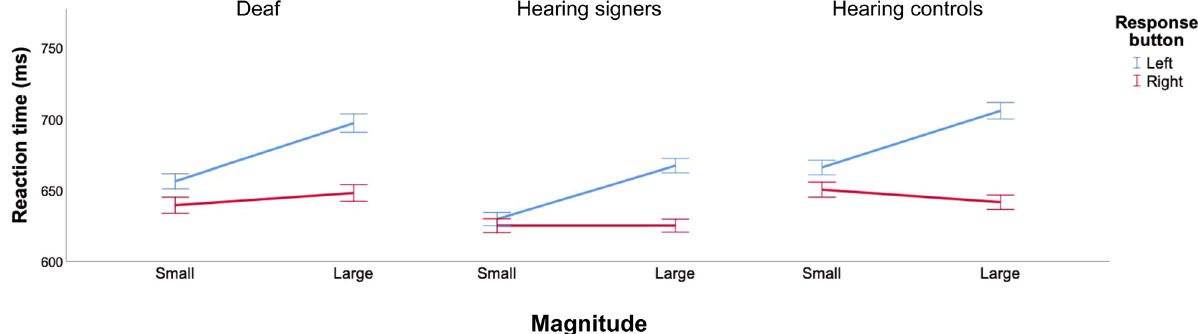
Figure 1. Mean reaction times for deaf (left graph), hearing signers (middle graph) and hearing controls (right graph) in the number comparison task. Error bars represent the standard error of the means. Untransformed reaction times are represented in the graph for the ease of